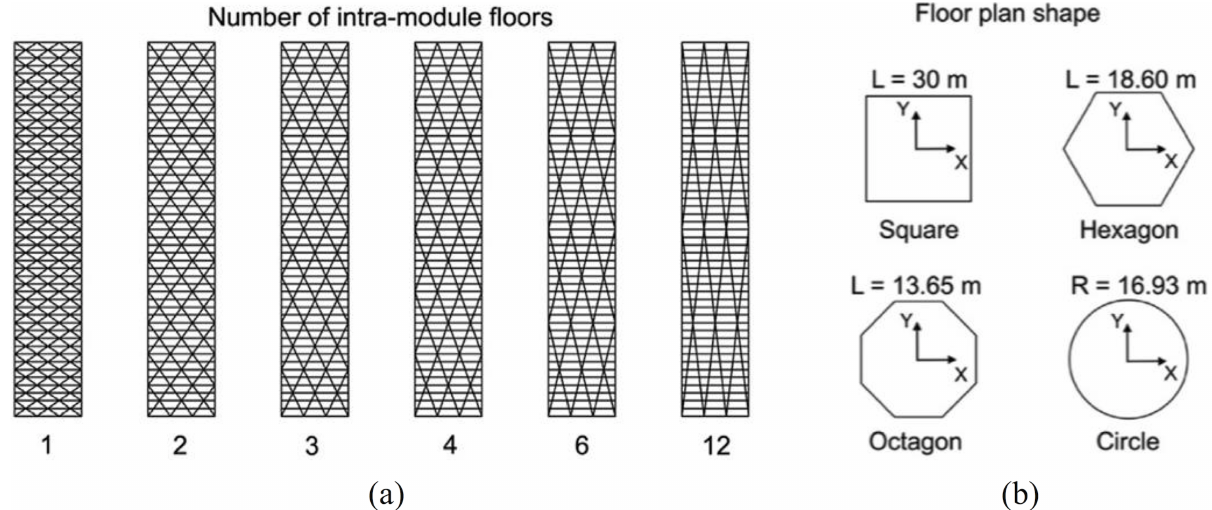
Figure 1: Diagrid geometries with different (a) diagonal inclination and (b) floor shape [20]